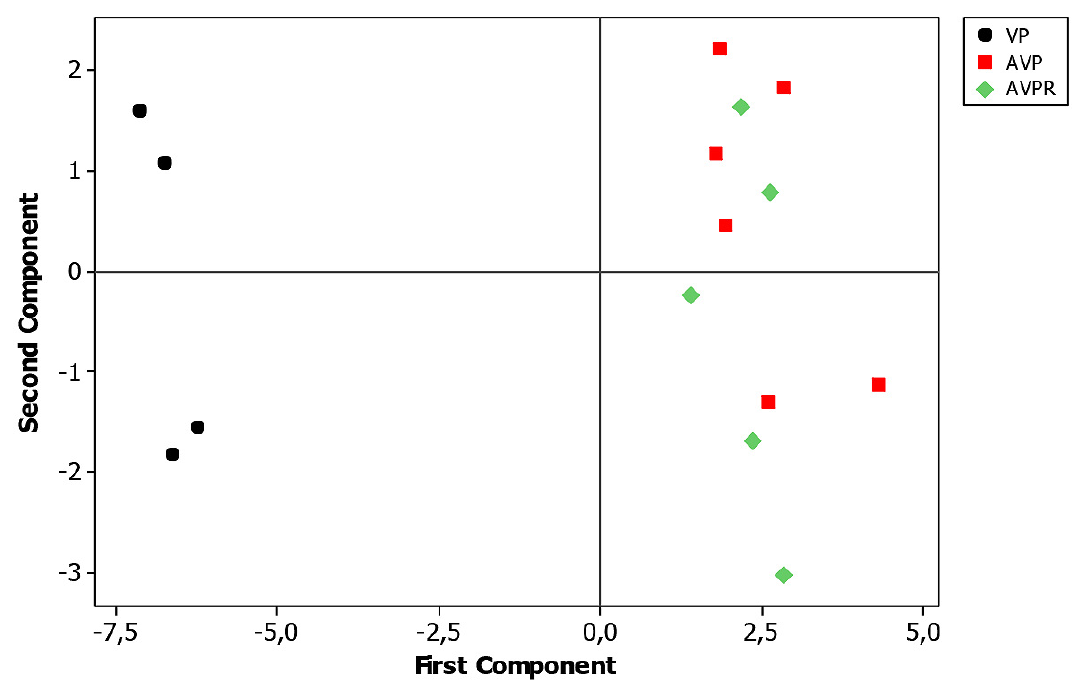
Figure 4. Principal component analysis of δ 13 C and δ 15 N values during experimental days 49 to 84.